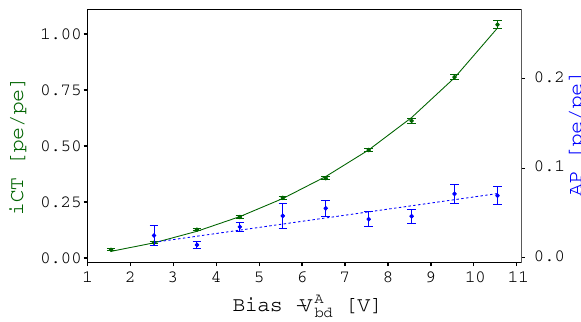
of photo-electrons measured in a gate of 7 µ s for single photo-electron events. Lines are drawn to guide the eyes